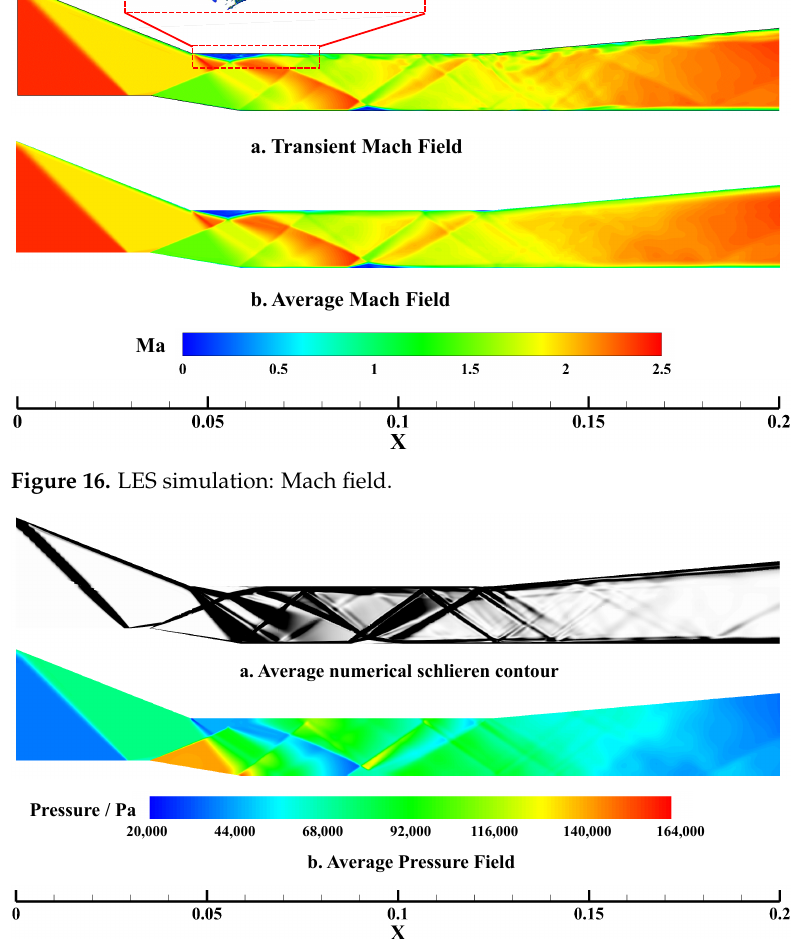
Figure 17. LES simulation: average fields of density gradient and